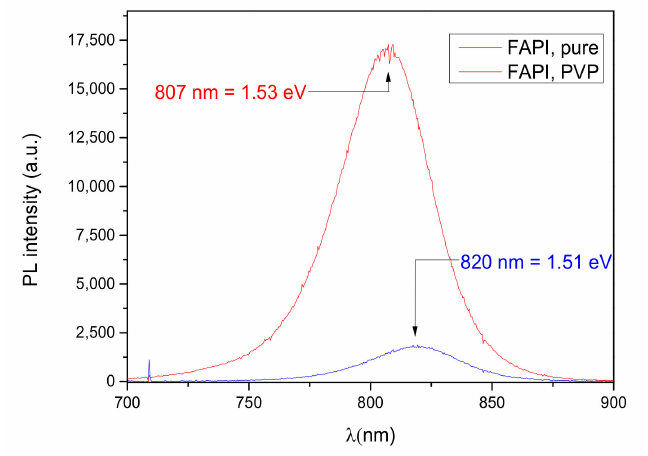
Figure 6. Photoluminescence spectra of FAPI thin film (pure) and FAPI thin film infused with PVP on glass substrate.